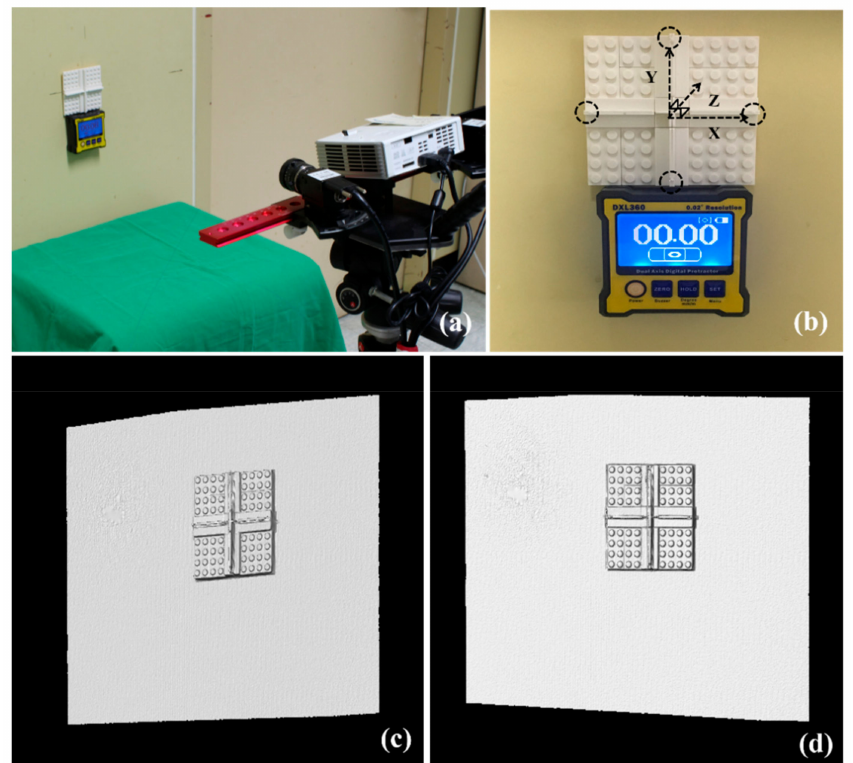
Figure 1. The calibration plate was attached to the wall parallel with the global horizon using a digital spirit level ( a ). The coordinate system of the calibration plate model was determined by the positions of four ceramic balls (indicated by the dashed circles) on the orthogonal cross of the calibration plate ( b ). The scanned model was positioned arbitrarily in the scanner coordinate system before calibration ( c ). The scanner coordinate system was aligned with the coordinate system of the calibration plate that was already oriented in the global horizon after calibration ( d